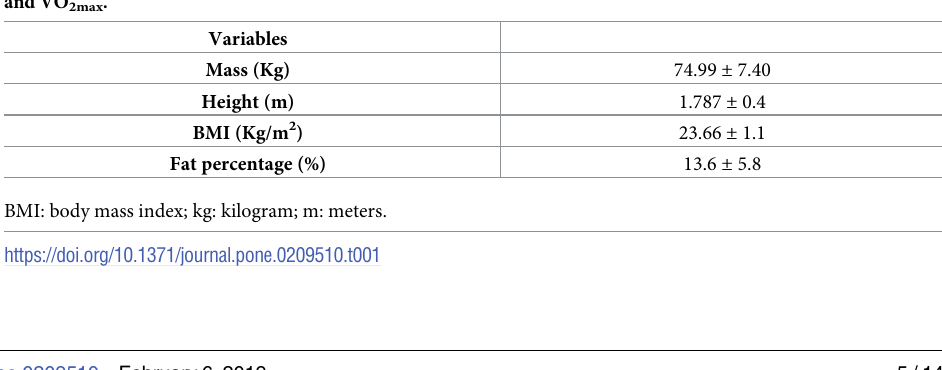
Table 1. Mean values followed by their respective standard deviations of age, mass, height, BMI, fat percentage and VO 2max .